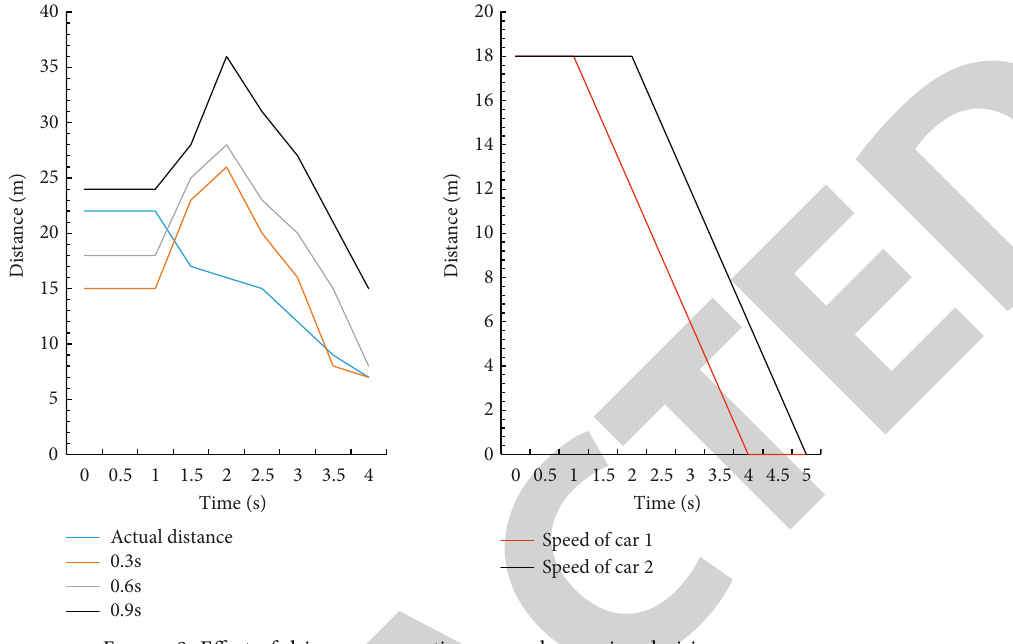
Figure 9: Effect of driver response time on early warning decision.